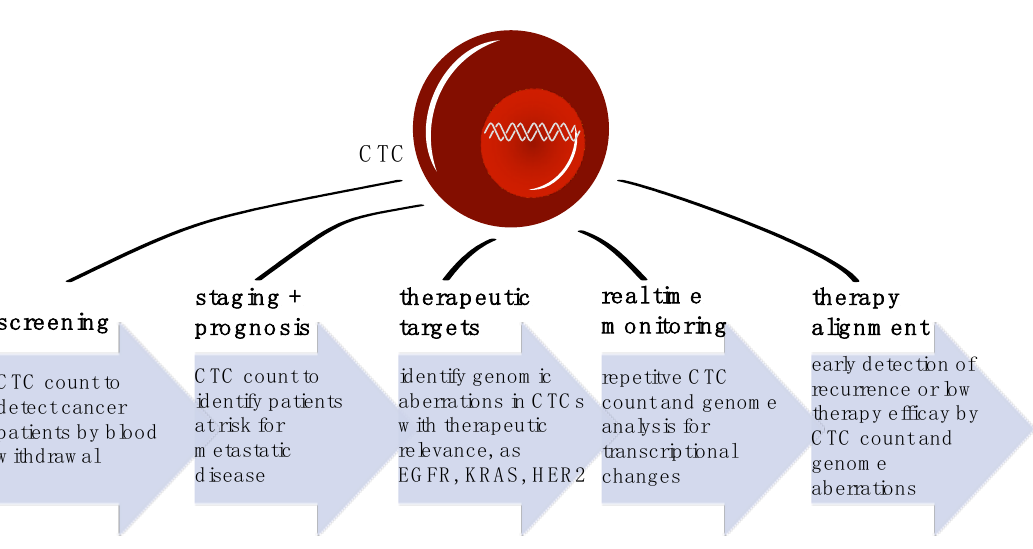
Figure 1. Clinical applications of CTC diagnostic in cancer patients at different timepoints of disease and therapy.